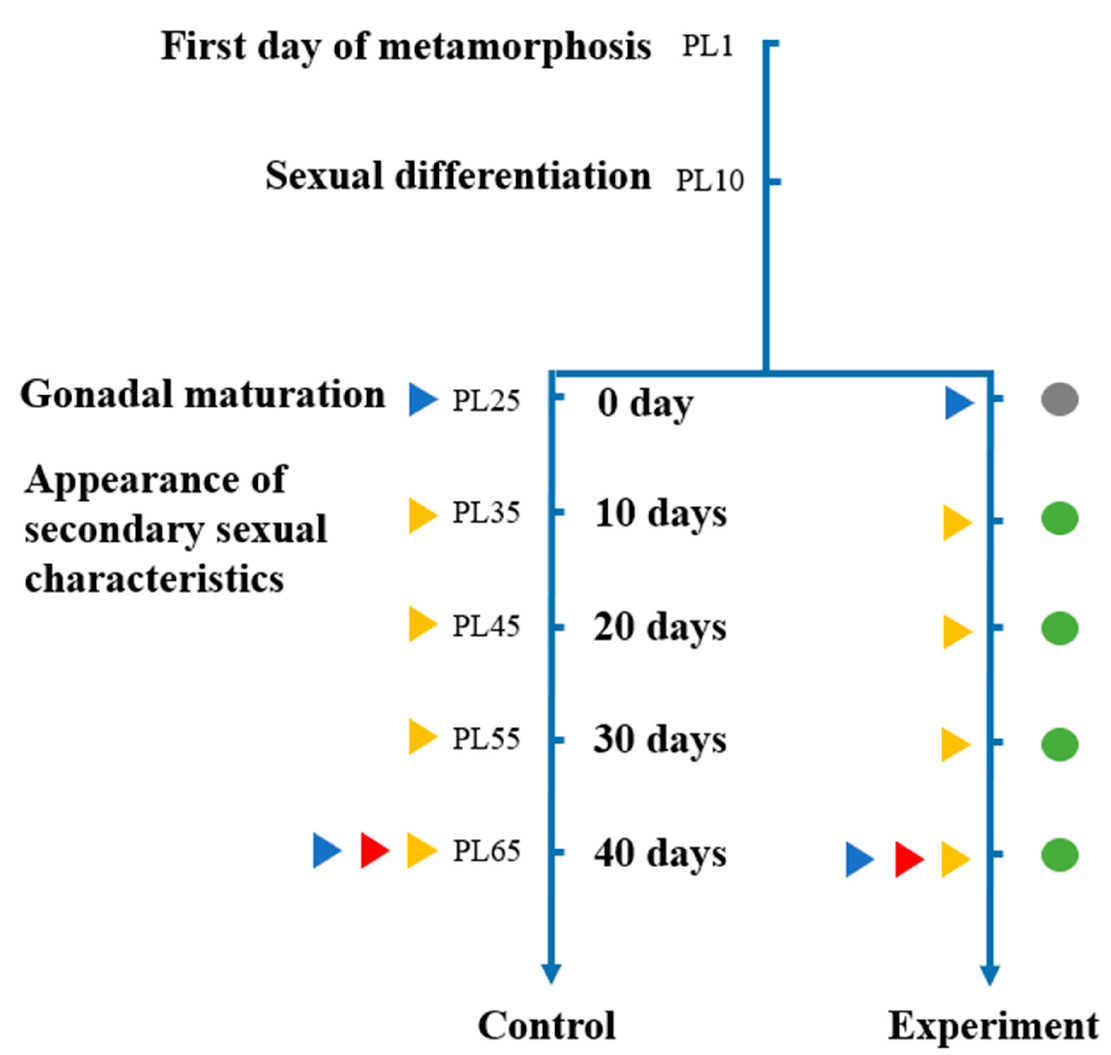
Figure 1. The start of the MT treatment was set as day 0 (PL25), and subsequent sampling stages were denoted as days 10, 20, 30, and 40.